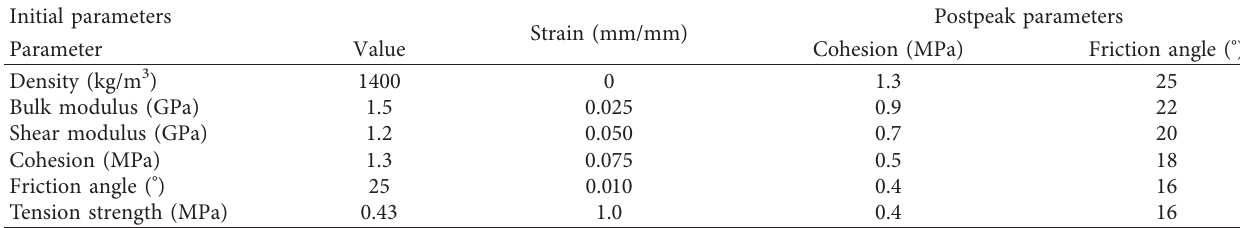
Table 1: Strain-softening parameters for chain pillar material.